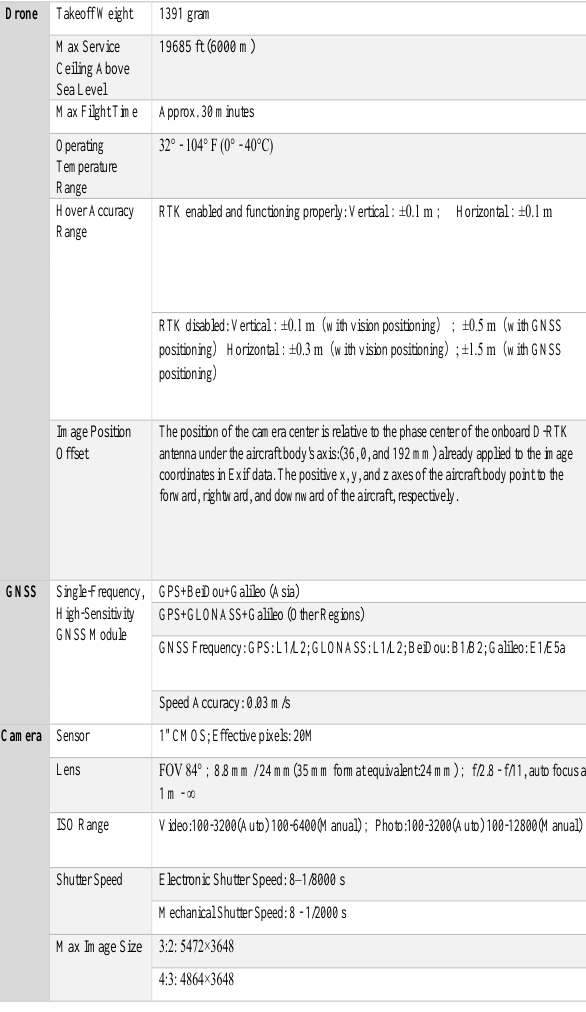
Figure 2. DJI Phantom 4 RTK UAV System.